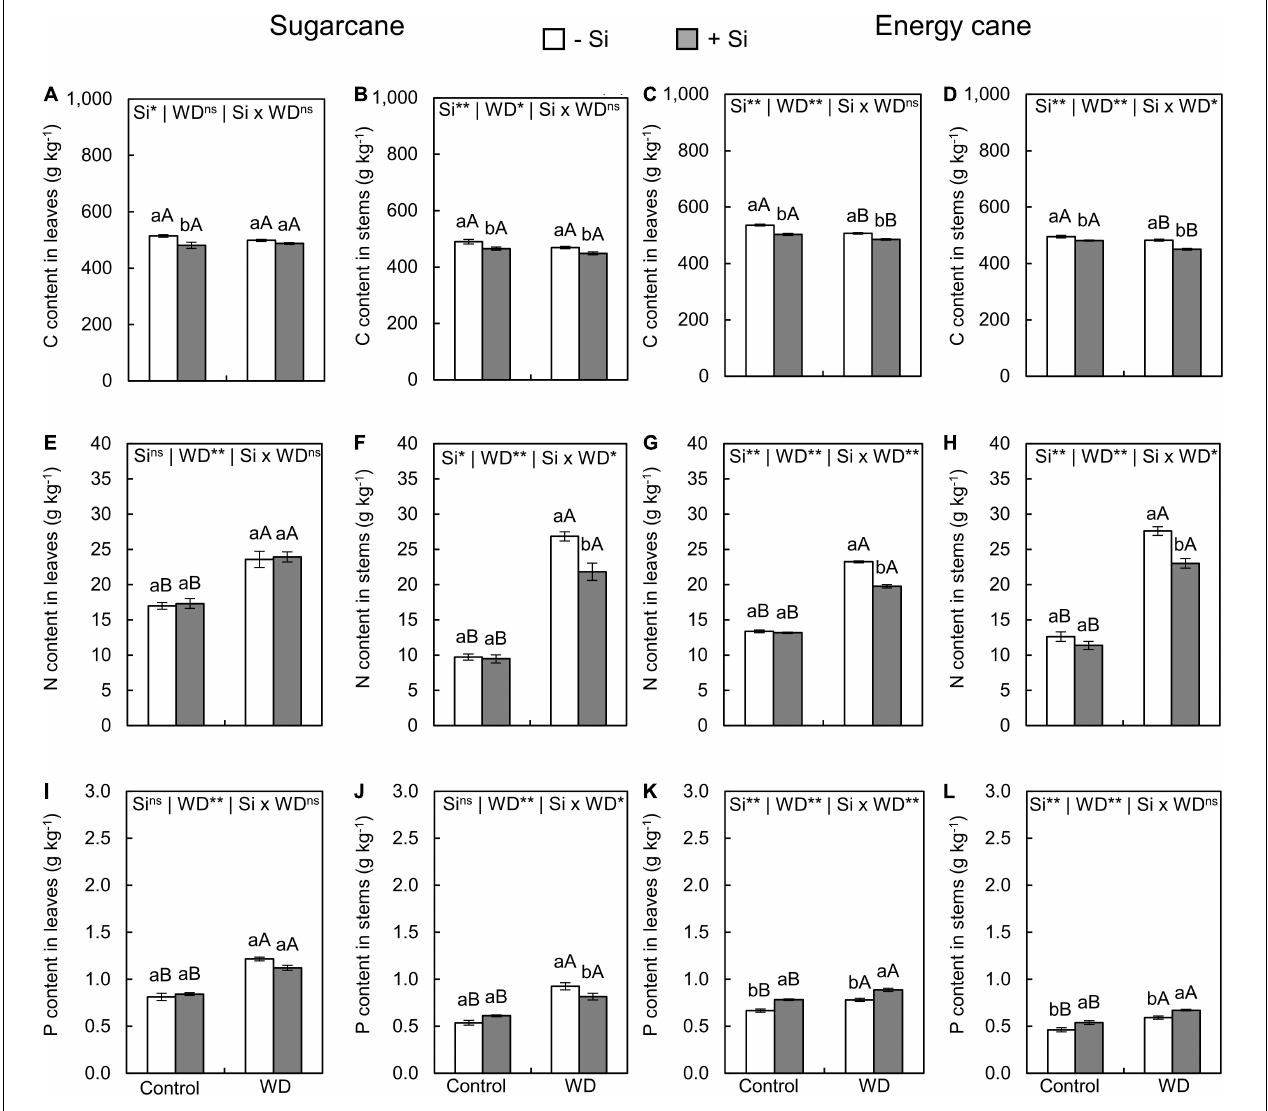
FIGURE 4 | Contents of C, N, and P in the leaves and stems of sugarcane (A,B,E,F,I,J) and energy cane (C,D,G,H,K,L) in -Si and + Si under adequate water regime (control) and in WD for a period of 7 to 160 days after transplantation. ** and * significant with 1 and 5% probability, respectively, and ns, not significant by the F -test. Lowercase letters indicate differences in relation to Si and capital letters in relation to water deficit. n = 5. Si × WD: